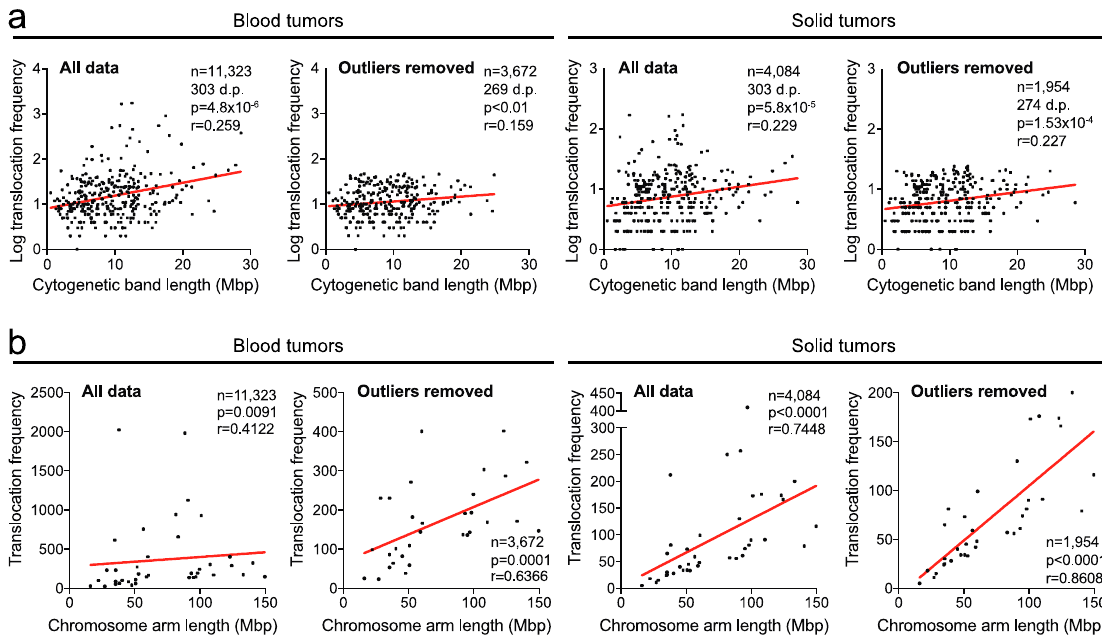
Figure 1. Translocation breakpoints preferentially occur in longer cytogenetic chromosome bands and arms. ( a ) Scatter plots of the cytogenetic chromosome band length in mega-base pairs (Mbp) and translocation frequencies within these bands in blood and solid tumors. Shown are analyses including all data, as well as analyses with data from which statistically identified outliers were removed (see main text). The latter was done to rule out the possibility that statistical significance was reached solely due to one or several highly frequent events which could skew the analyses. p and r values: Spearman correlations. D.p., data points. ( b ) Scatter plots as in ( a ) but at chromosome arm level.